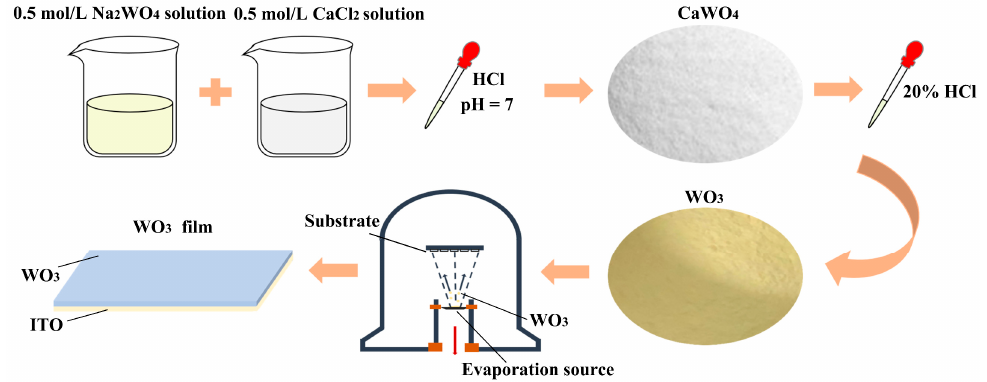
Figure 1. Preparation process diagram of nanostructured WO 3 powder and